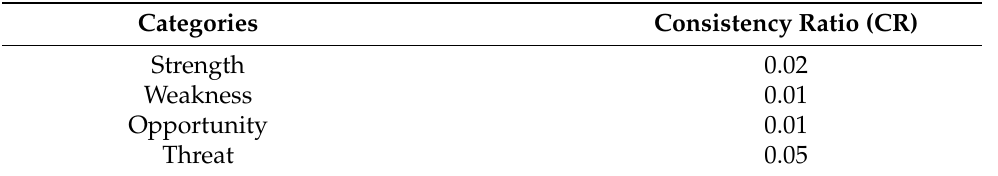
Table 11. Calculated consistency ratio (CR) values.